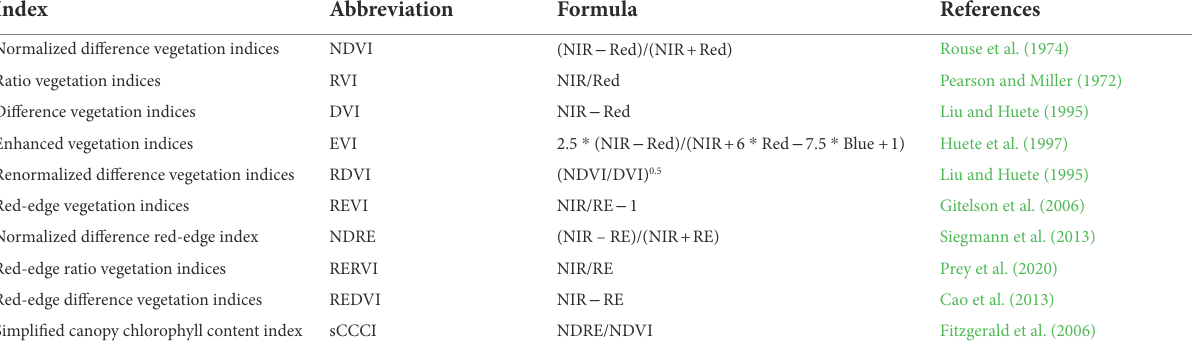
TABLE 3 The information of MS